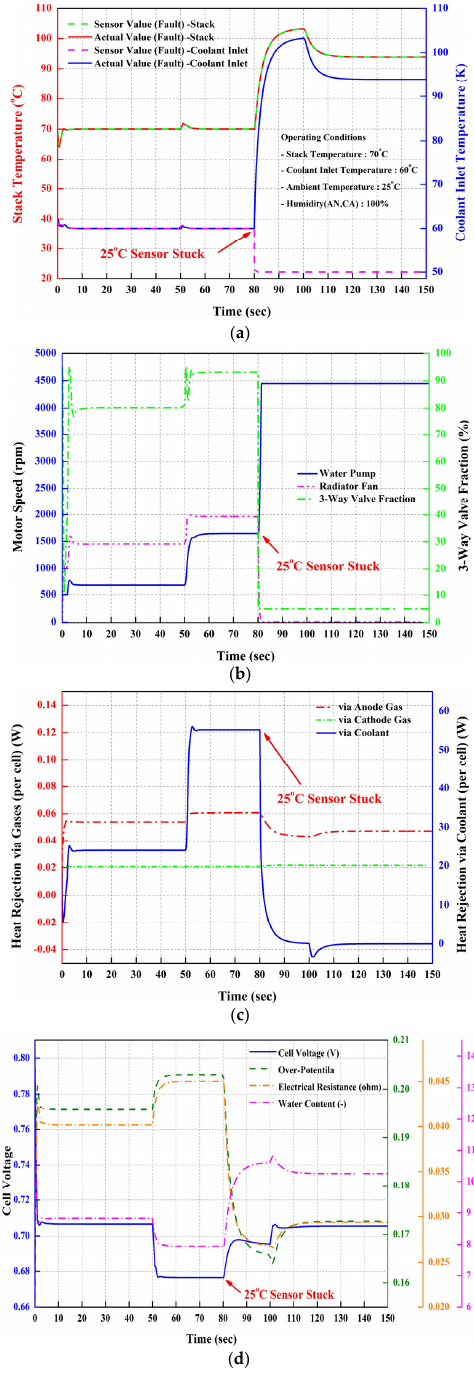
Figure 7. Transient sensor fault behavior in PEM fuel cell under sudden coolant inlet sensor stuck (( a ) Temperature of stack and coolant inlet, ( b ) cooling components, ( c ) heat rejection in stack, ( d ) voltage responses).